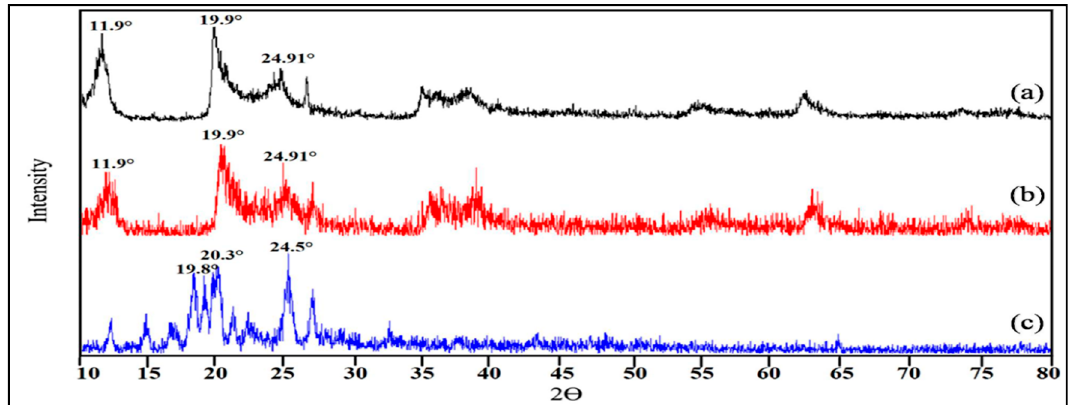
Figure 2. X-ray diffraction patterns of ( a ) Halloysite nanotubes (HNTs); ( b ) Chlorhexidine-loaded Halloysite nanotubes (HNT/CHX); ( c ) Chlorhexidine (CHX).